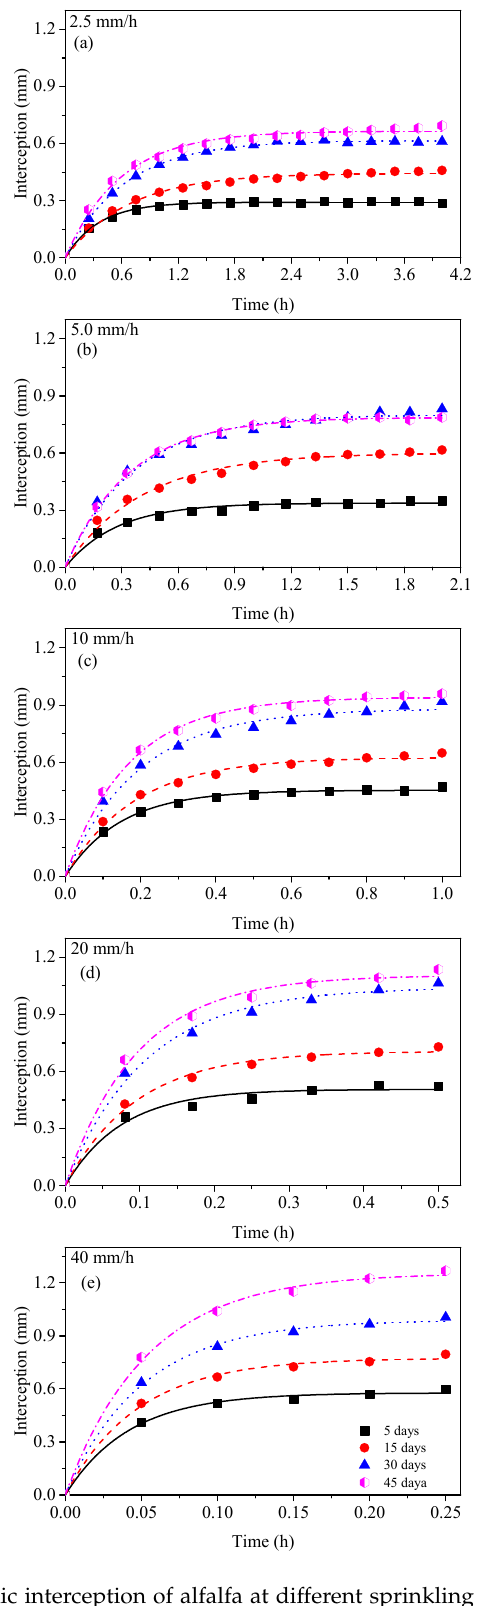
Figure 3. Canopy dynamic interception of alfalfa at different sprinkling intensities (2.5 ( a ), 5.0 ( b ), 10 ( c ), 20 ( d ), and 40 mm/h ( e )) during different vegetative stages. The dots indicate the observed values, and the curves are the fitting results. The legend (5, 15, 30, and 45 days) indicates the number of days after the most recent harvest of alfalfa.